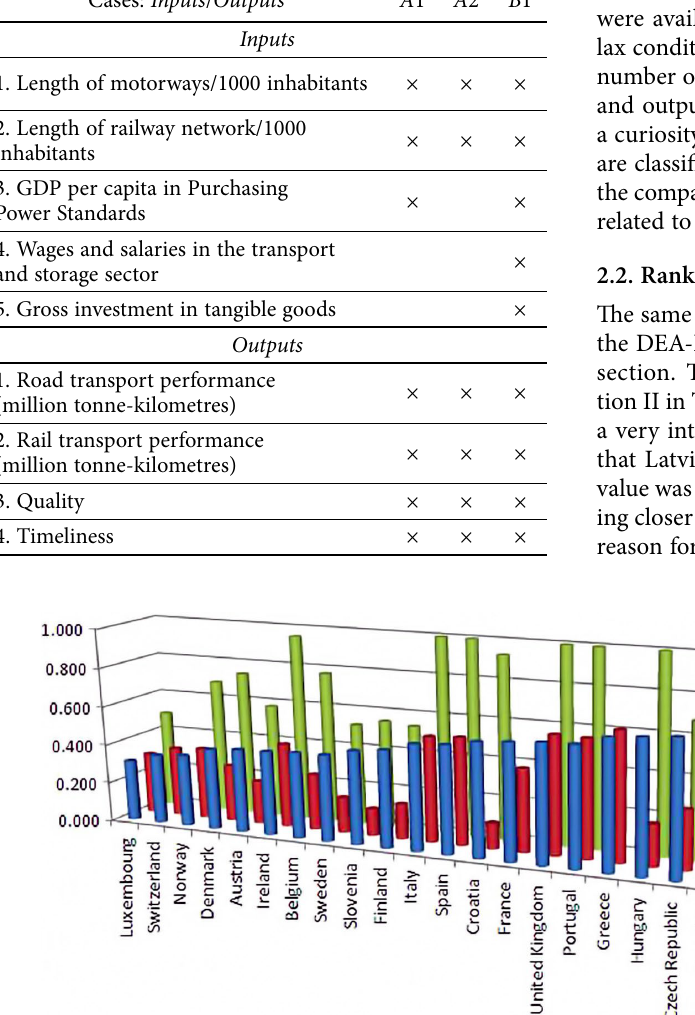
Table 1. Description of inputs and outputs in the different cases (Markovits-Somogyi 2011a) Cases: Inputs /